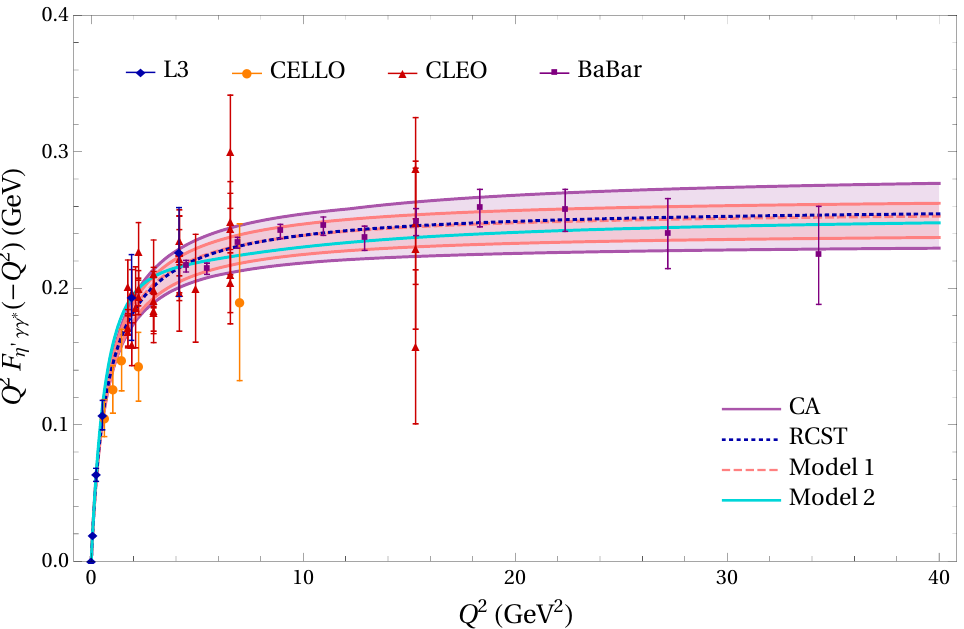
Figure 11. Singly-virtual (cid:17) 0 TFF. The large- N c Regge model, \Model 1" (4.34), is indicated by the pink band with the dashed curve. Our alternative TFF model, \Model 2" (B.1), is indicated by the solid cyan curve. The purple band is the CA result from ref. [49]. The dark blue dotted curve is the RCST result from ref. [125]. The data are from L3 [127], CELLO [115], CLEO [116], and BaBar